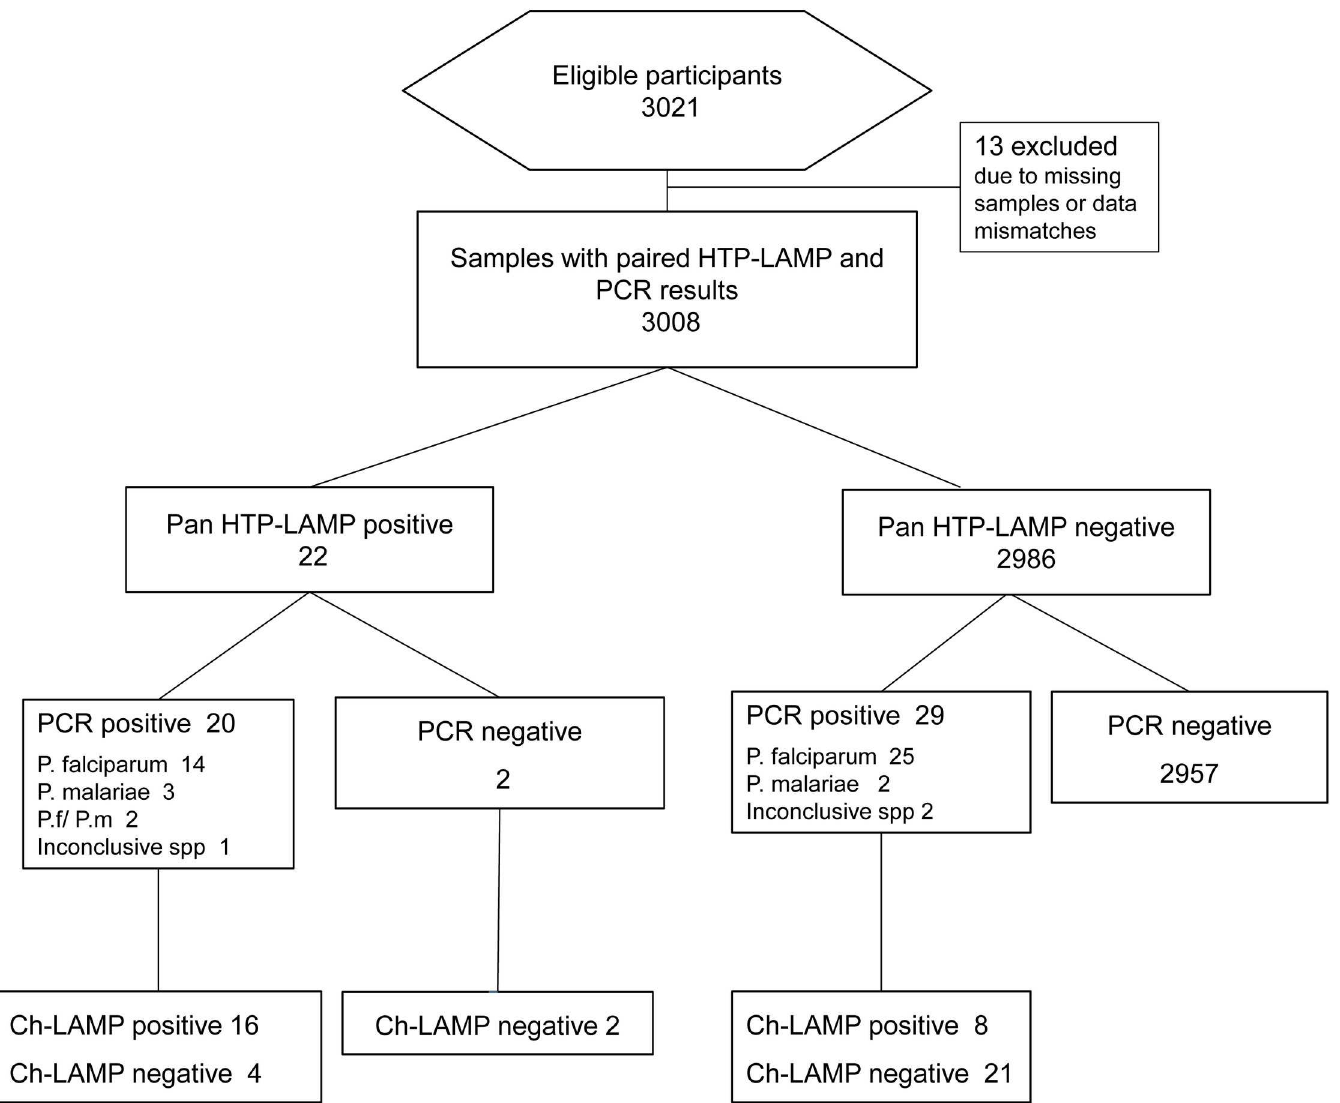
Fig 3. Flow chart of high-throughput (HTP)-LAMP evaluation. Results of Pan Plasmodium HTP-LAMP, confirmedPCR and ChelexLAMP (Ch-LAMP) are summarized.